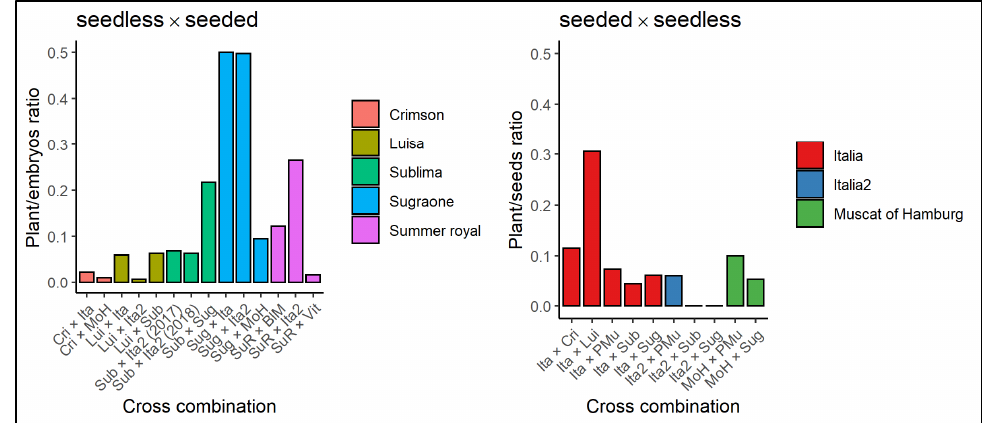
Figure 4. Ratio of the plant and the number of embryos or seeds: seedless × seeded; seeded × seedless.